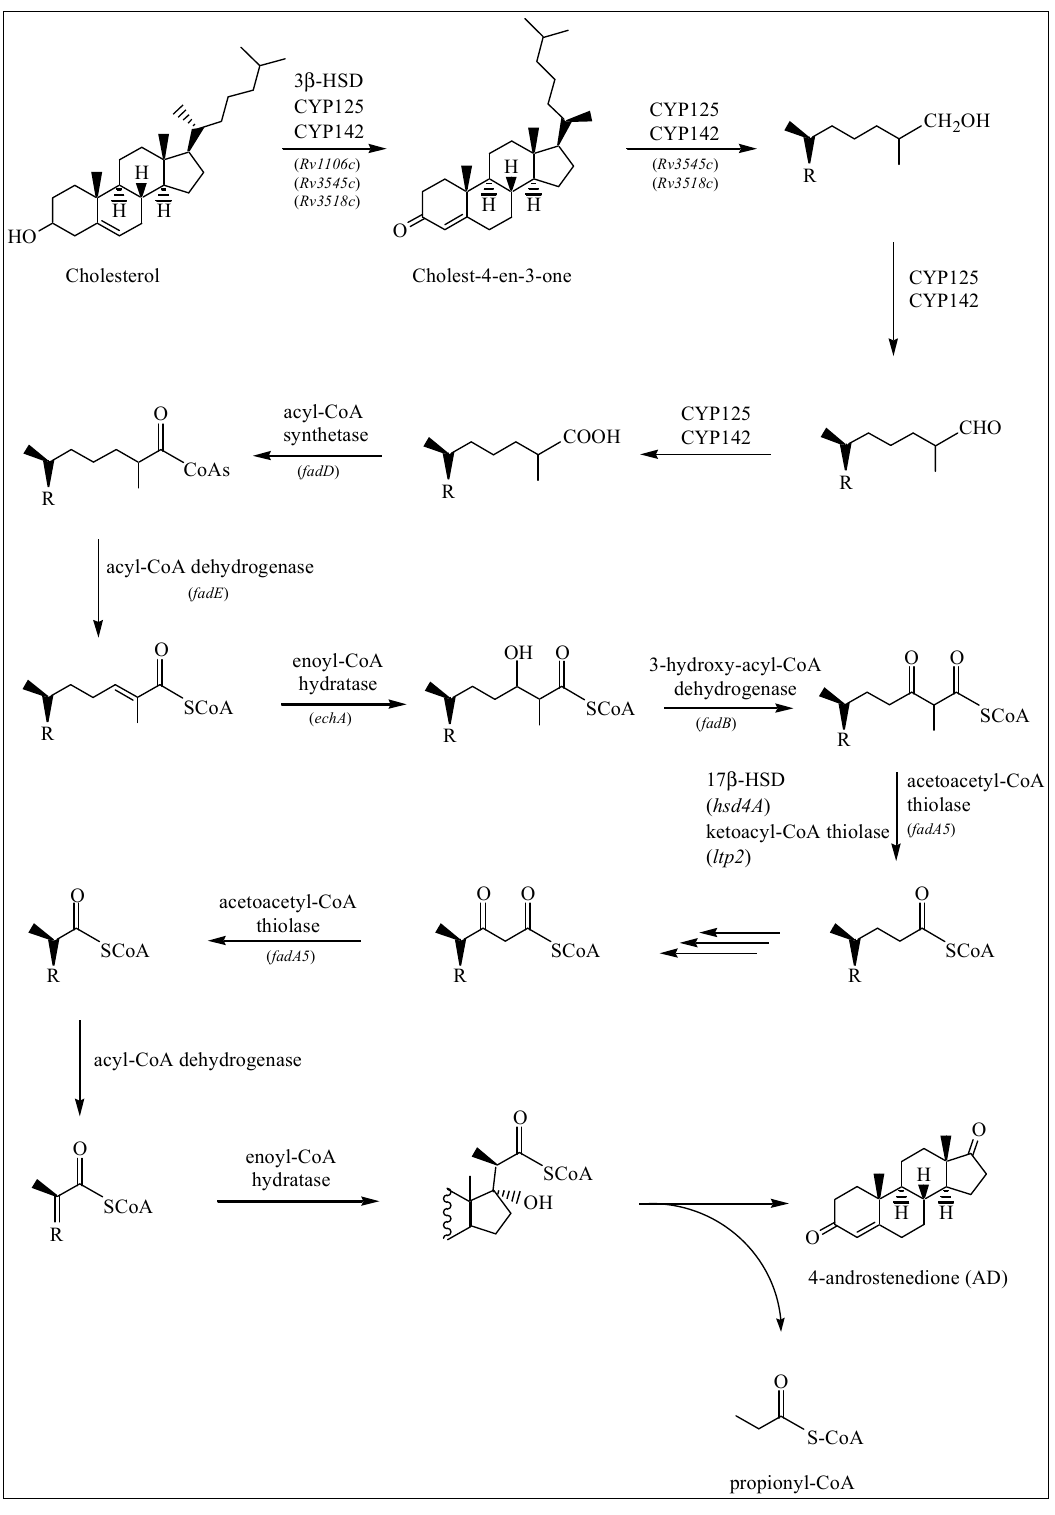
Figure 1. Cholesterol side chain degradation as described in Section 2.1.1. If known, the enzymes involved in each reaction are depicted by arrows, along with the gene coding for the specific enzyme.